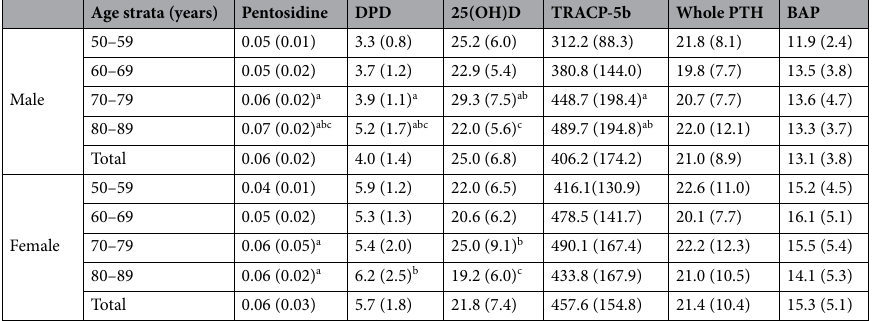
Table 4. Bone markers and 25-hydroxyvitamin D. Values represent mean (standard deviation). DPD: deoxypyridinoline, 25(OH)D: 25-hydroxyvitamin D, TRACP-5b: tartrate-resistant acid phosphatase 5b, PTH: parathyroid hormone, BAP: bone alkaline phosphatase. a Significantly different (p < 0.05) values from those aged 50–59 years. b Significantly different (p < 0.05) values from those aged 60–69 years. c Significantly different (p < 0.05) values from those aged 70–79 years.